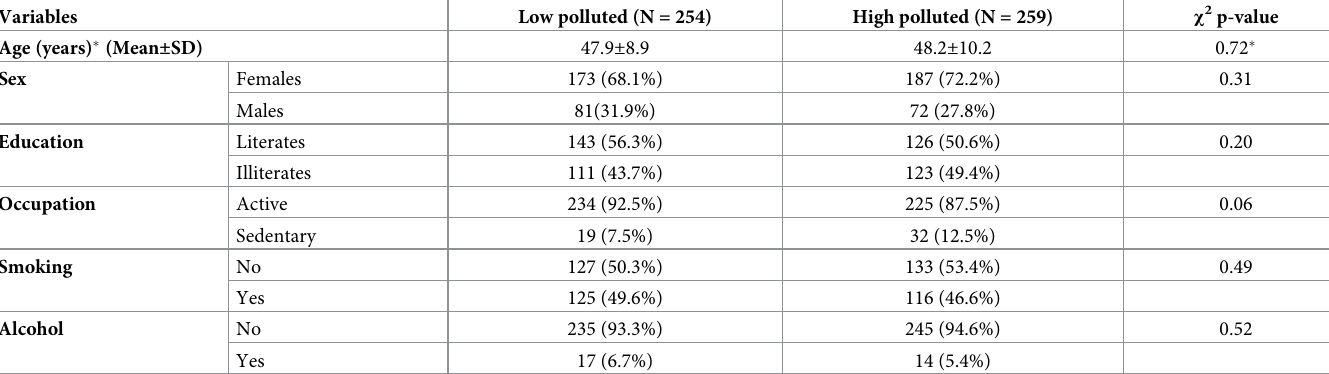
Table 1. Distribution of demographic and lifestyle variables among individuals in low and high polluted areas.